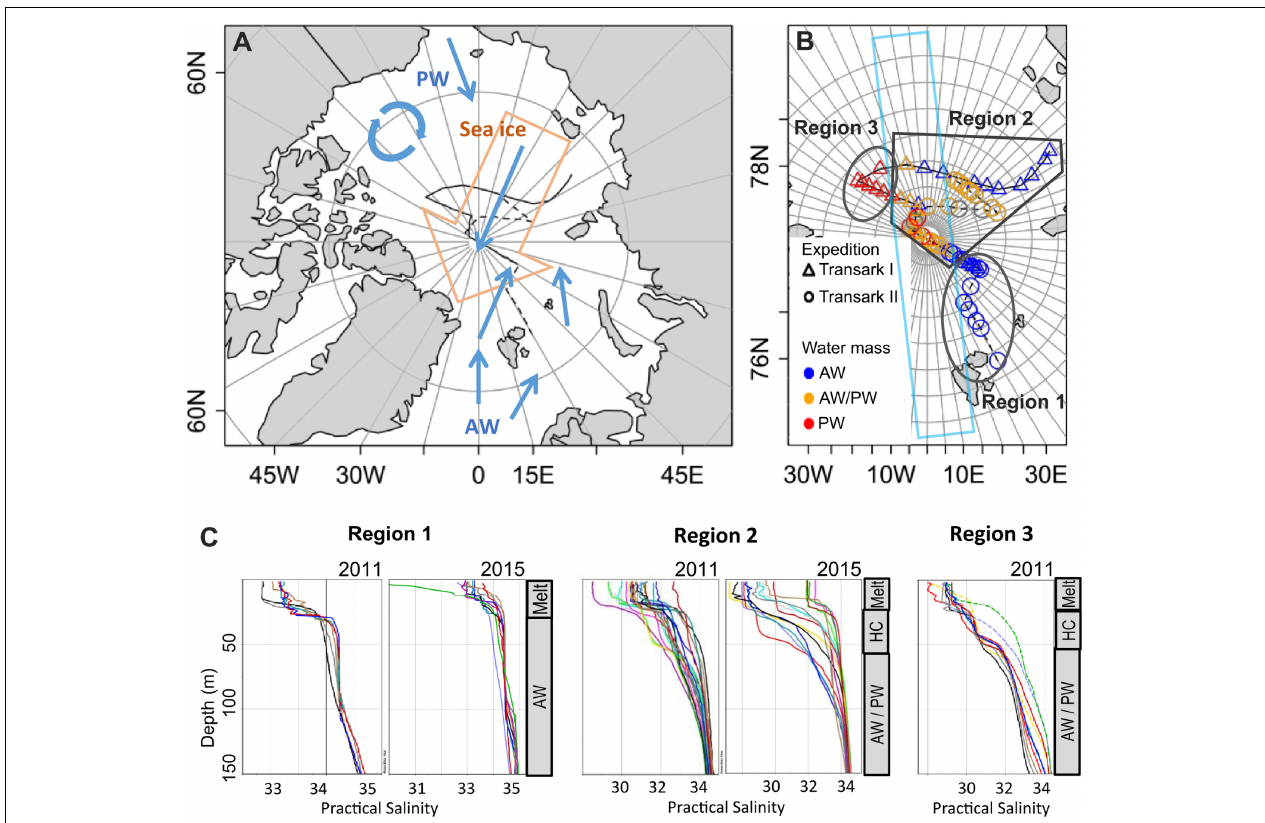
FIGURE 1 | Study area (A) , station map (B) , and salinity profiles in the upper 150 m of the water column (C) . (A) Schematic of general surface water (blue arrows) and sea ice (orange arrow) movement relevant for our study. Atlantic water (AW) enters the central Arctic via Fram Strait, Pacific water (PW) via the Bering Strait. The black lines indicate the cruise tracks Transark I 2011 (solid) and Transark II 2015 (dashed). Adapted from Ulfsbo et al. (2014) and Damm et al. (2018). (B) Stations during expeditions Transark I 2011 (triangles) and Transark II 2015 (circles), covered a broad area of the central Arctic Ocean spanning different water masses. Colors show the water mass dominating in the surface layer ( < 25 m). Region 1 is dominated by AW, Region 2 is characterized by a mix of nutrient signatures, while Region 3 is dominated by PW. The light blue box indicates the approximate coverage of previous studies in the central Arctic from Levasseur (2013). (C) Salinity profiles in the different regions for both years. Sea ice melt from the current season (Melt) causes the lower salinity in the upper 25 m. In Region 1, directly beneath is the AW. In Regions 2 and 3, the mixed AW/PW water is separated from the meltwater layer by a second halocline (HC). The gray bars on the right show the general structure of the water column. Note the different x -axis